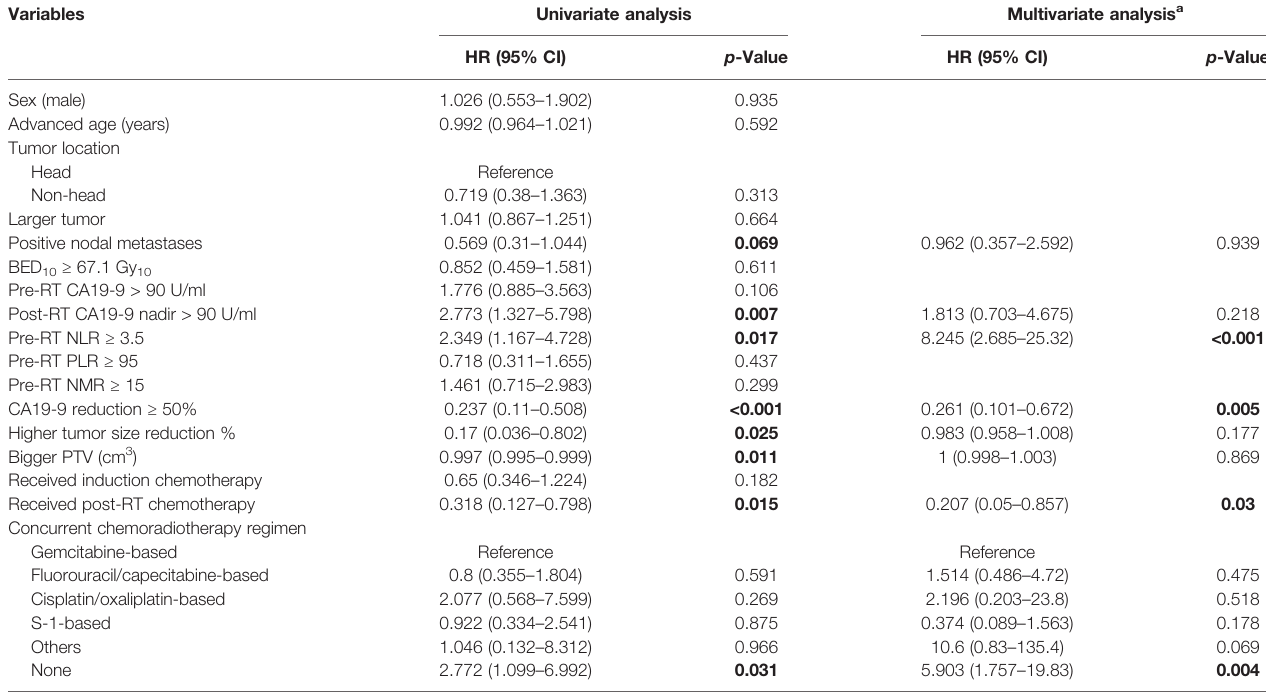
TABLE 2 | Univariate and multivariate analyses of factors associated with overall survival in inoperable pancreatic adenocarcinoma (Cox regression).